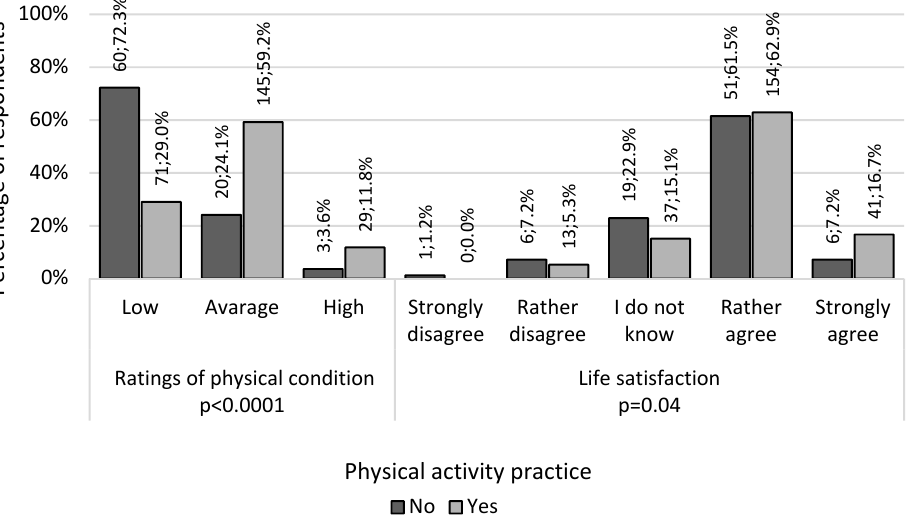
Figure 2. Summary of subjective ratings of physical condition and life satisfaction in relation to physical activity practice participation.